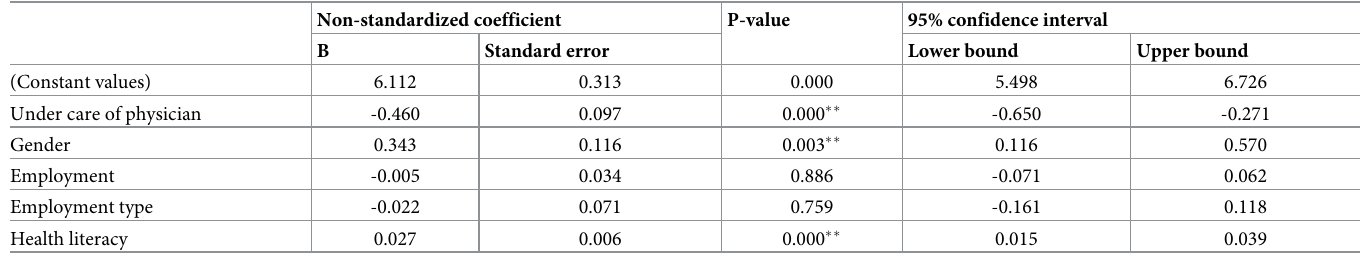
Table 6. Multivariate linear regression analysis of preventive action, predictive factors.